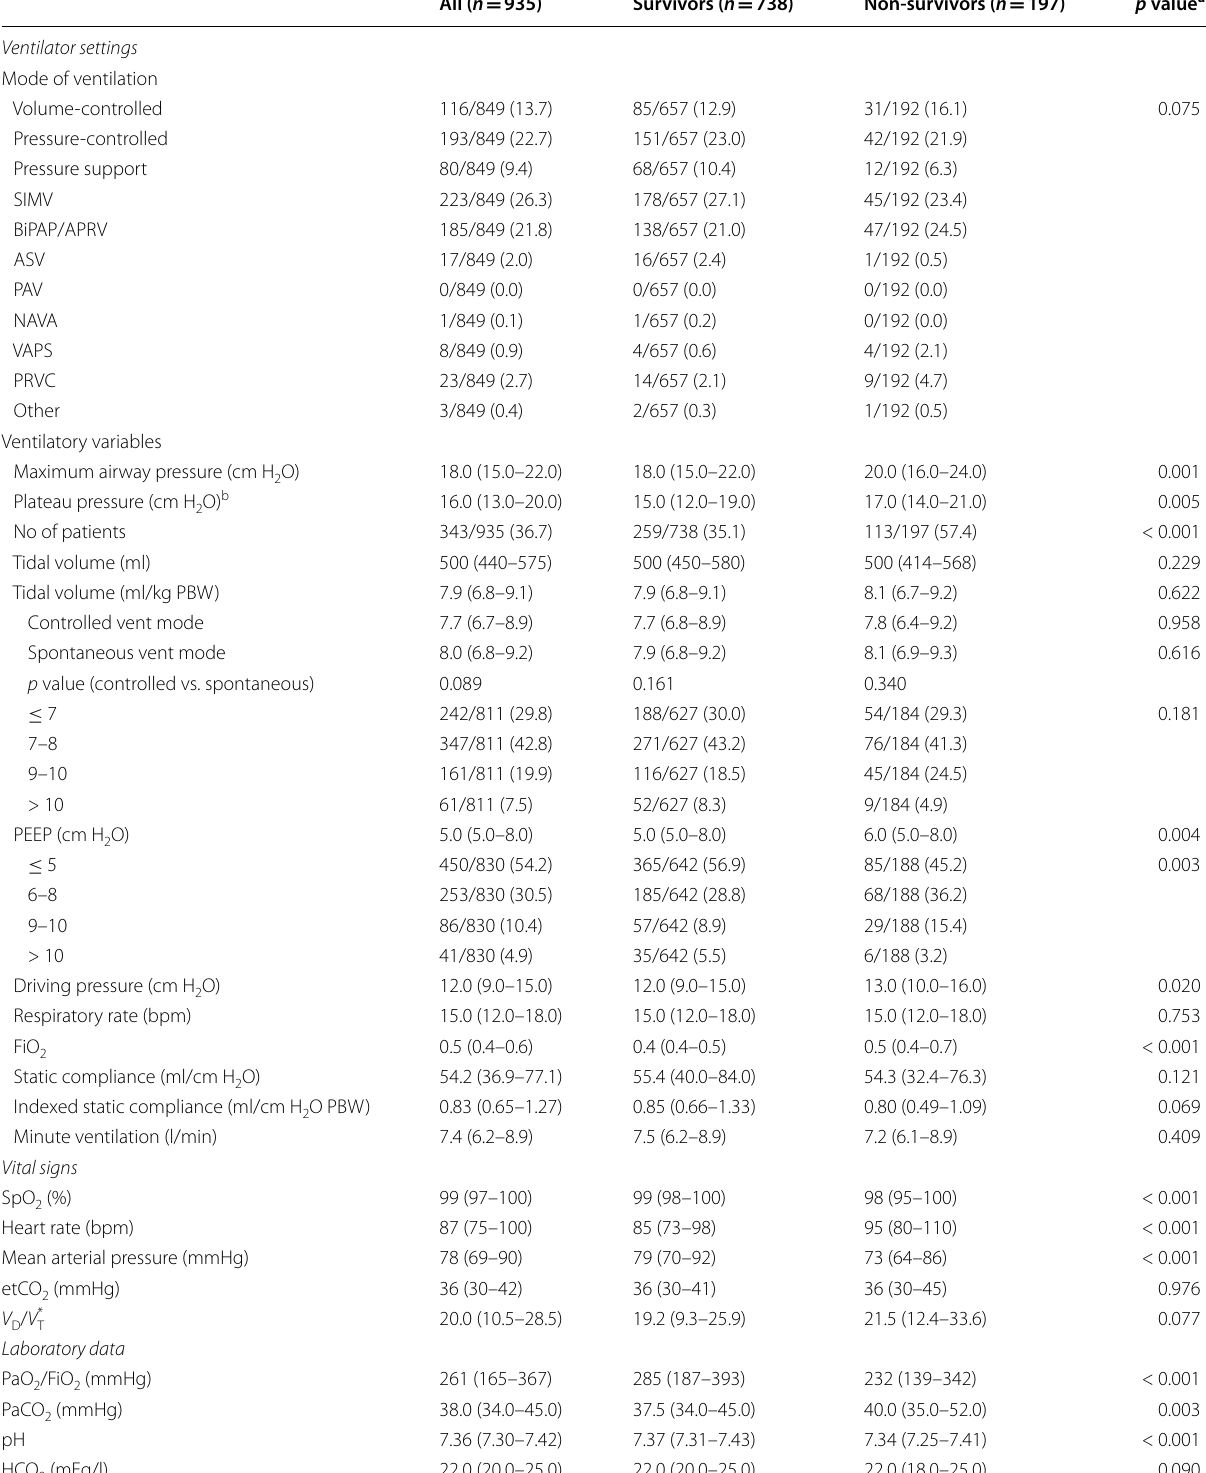
Table 2 Characteristics of critically ill patients without ARDS receiving mechanical ventilation, comparison of